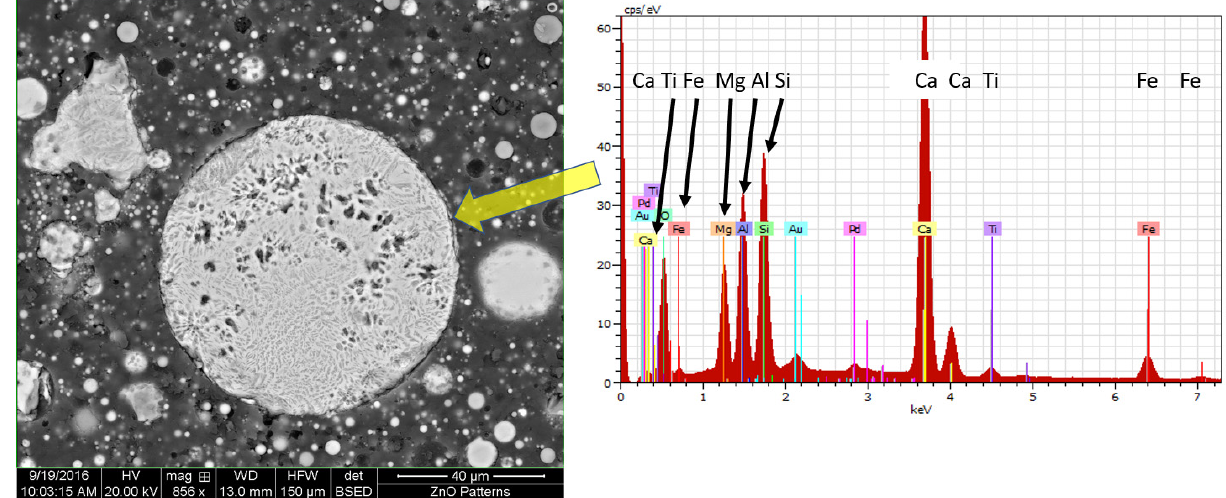
Figure 2. Left/ Back-scatter image of Ca-Mg-Al-Si-Ti-Fe grain. Scale = 40 μ m. Right/ EDS spectrum of elemental composition of large particle. Signals for Au and Pd are extraneous to the sample.